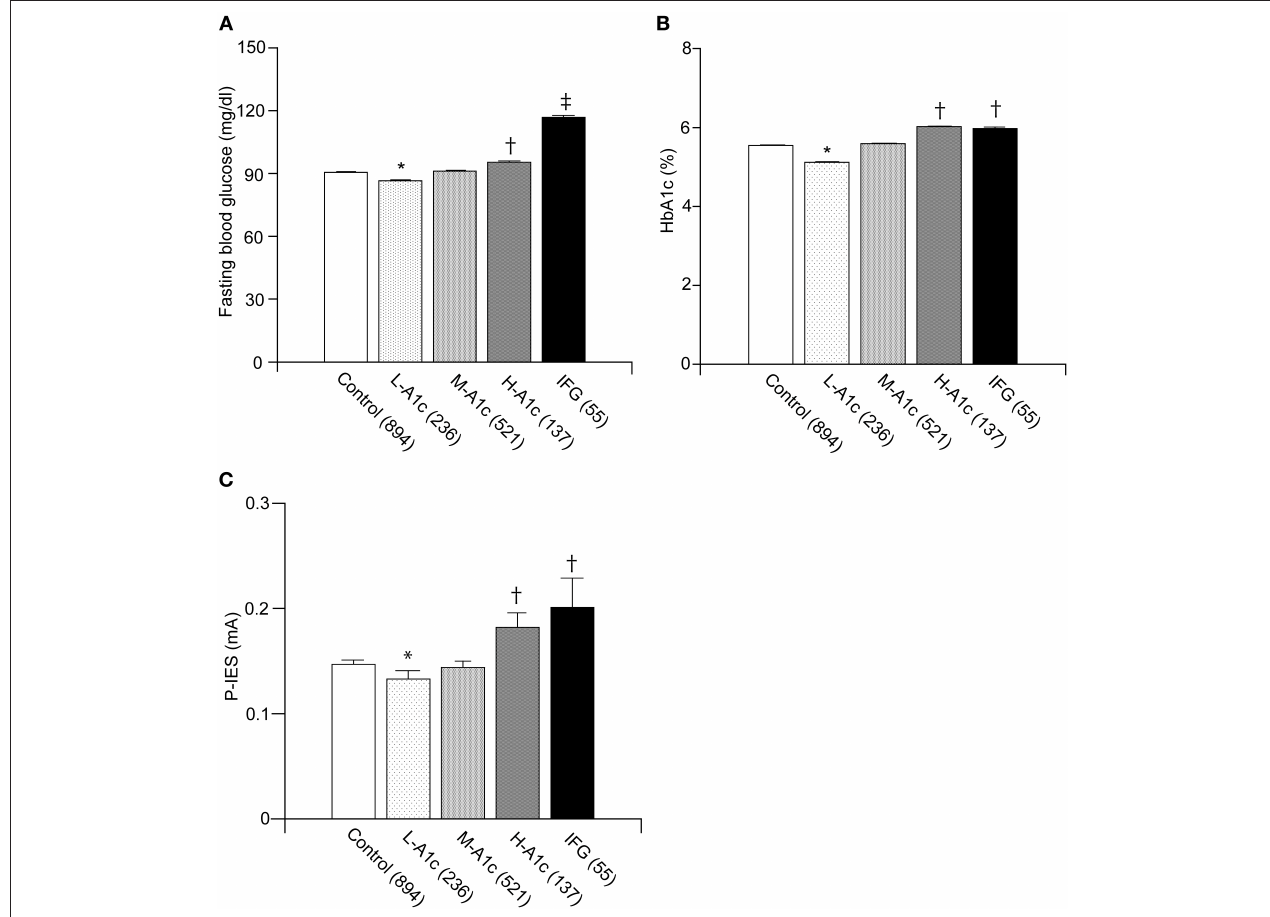
FIGURE 3 | Comparison between IFG and each group of graded HbA1c in normoglycemic individuals. Fasting blood glucose values were in parallel with L-A1c, M-A1c, and H-A1c (A) . HbA1c and P-IES of IFG were comparable to those of H-A1c (B,C) . L-A1c, HbA1c low; M-A1c, HbA1c moderate; H-A1c, HbA1c high. Mean